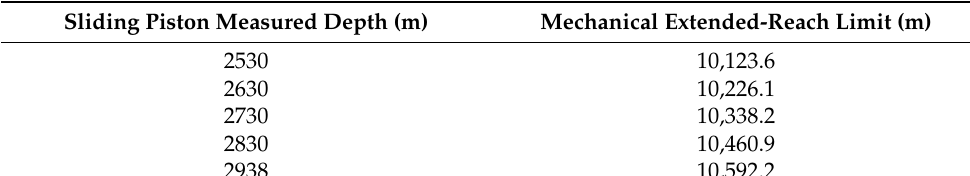
Figure 7. Effect of the sliding piston back pressure on the mechanical extended-reach limit.